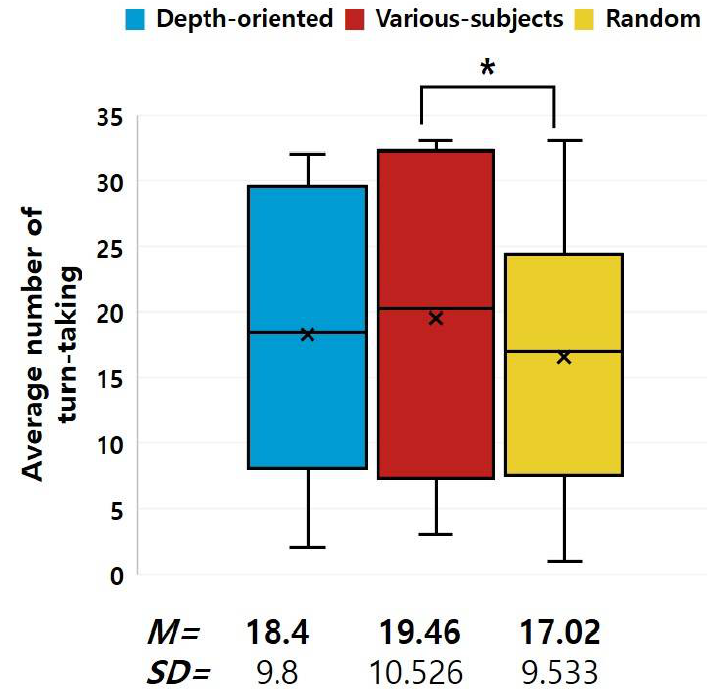
Figure 6. Average turn taking number by each model.